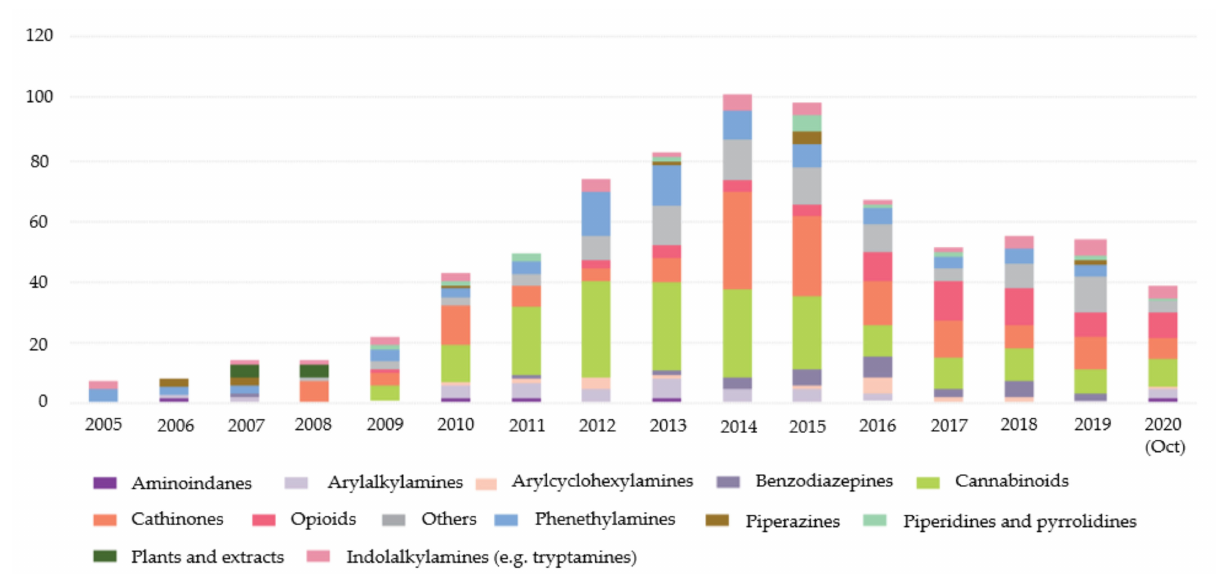
Figure 1. New psychoactive substances reported for the first time from 2005 to 2020 (October) divided by categories [5].